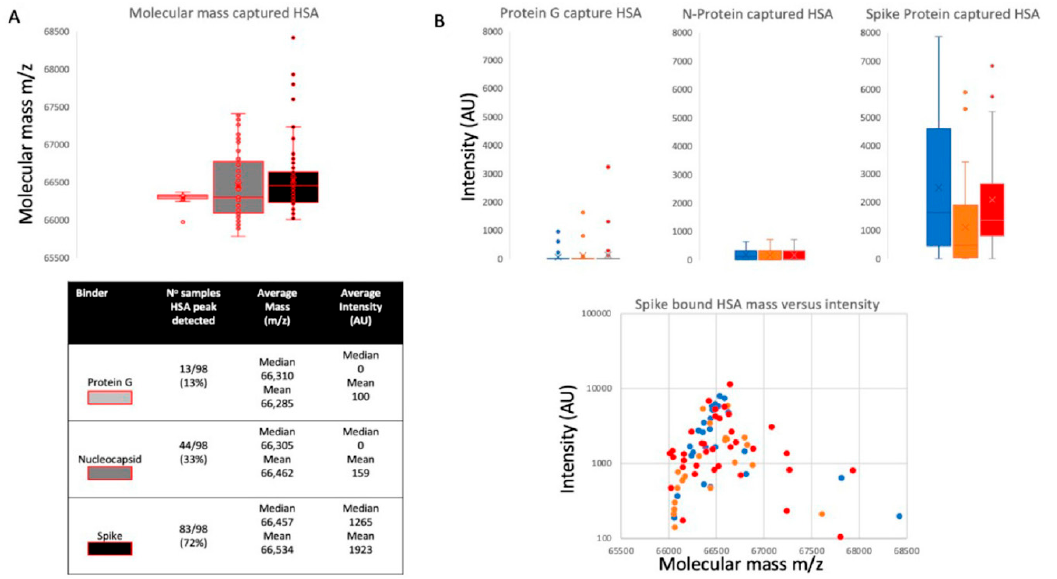
Figure 3. Distribution of mass determined for captured and eluted human serum albumin (HSA) and the relative intensity of the increased mass of bound albumins: Panel A illustrates the mass variance of protein G, nucleocapsid (N protein) and stabilised complete spike protein along with average intensity. Panel B illustrates a lack of differences in HSA binding by protein G, nucleocapsid and stabilised complete spike protein among the patient group’s plasma samples, whilst there is a clear preference of the S protein to bind higher molecular weight albumin in all samples. Blue represents data from SARS-CoV-2 seronegative HCWs, orange represents data from SARS-CoV-2 seropositive HCWs who have recovered from the infection with mild symptoms, and red represents sample data from convalescent patients recovering from COVID-19